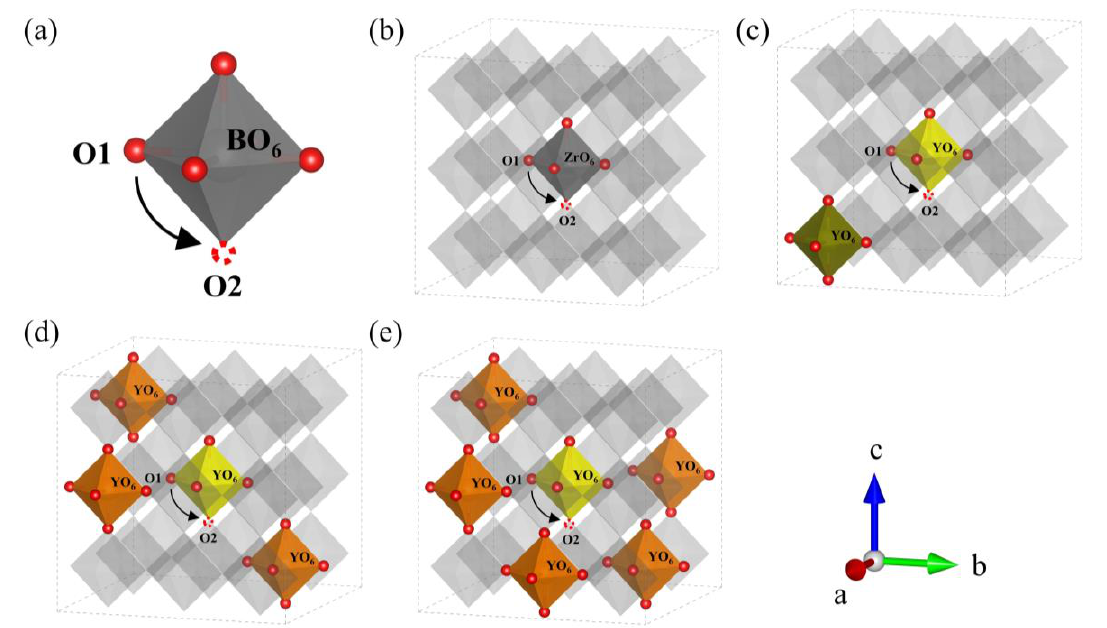
Figure 7. ( a ) Schematic diagram of the oxygen ion migration pathway in BO6 (B = Zr, Y). Migration pathway of oxygen ion in ( b ) BZY0, ( c ) BZY7.4_3, ( d ) BZY14.8_2, and ( e ) BZY22.2_4.